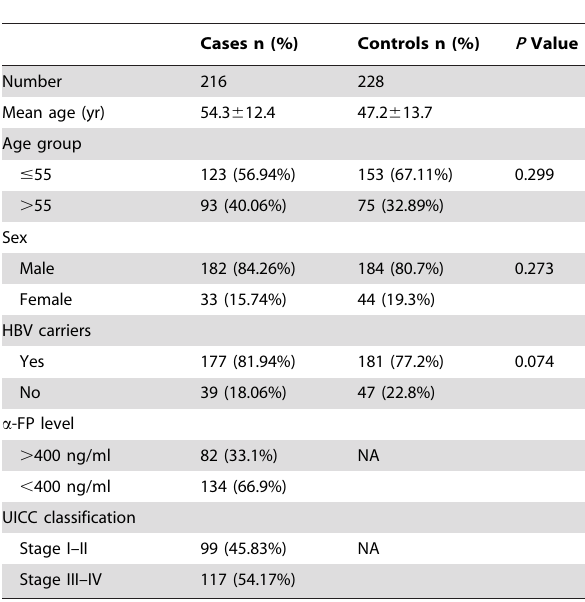
Table 1. Baseline characteristics of hepatocellular carcinoma cases and controls.